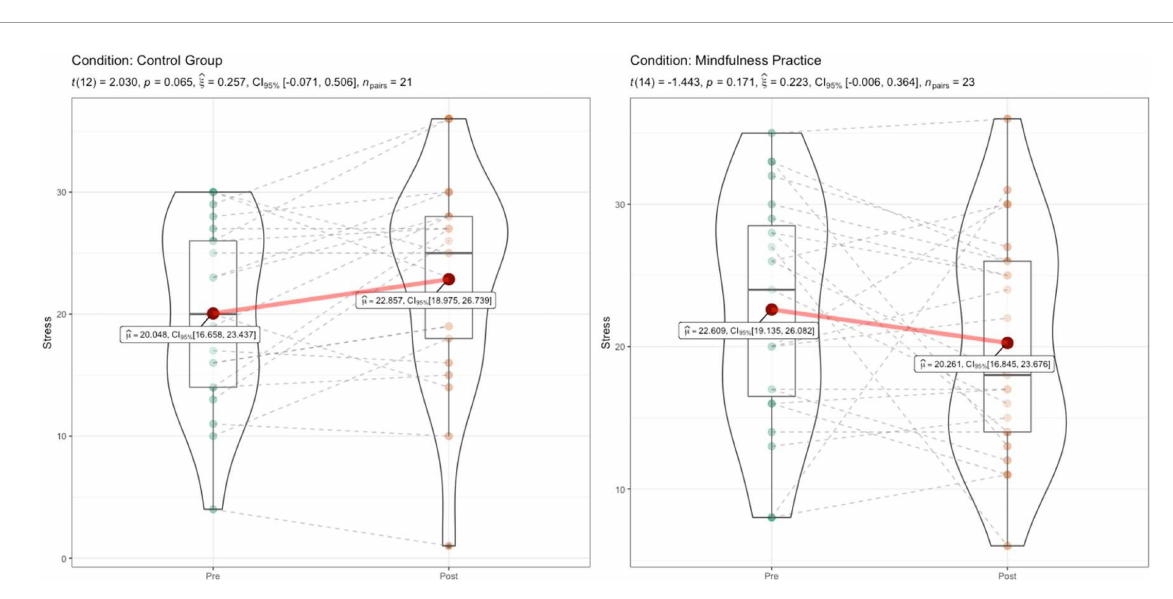
FIGURE3 Evolution of the experimental and control condition between moments T1 and T2, in the stress